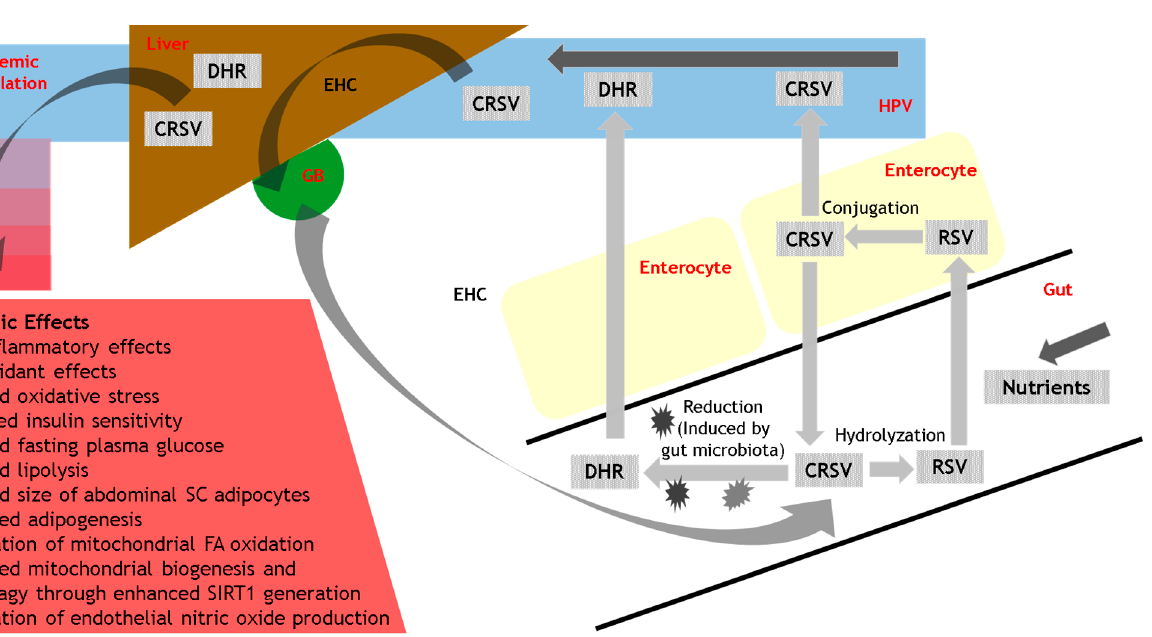
Figure 1. Schematic outline of resveratrol metabolism and biological actions. CRSV = Conjugated resveratrol; DHR = Dihydroresveratrol; EHC = Enterohepatic circulation; FA = Fatty acid; GB = Gallbladder; HPV = Hepatic Portal Vein; RSV = Resveratrol; SC = subcutaneous; SIRT1 = sirtuin 1.